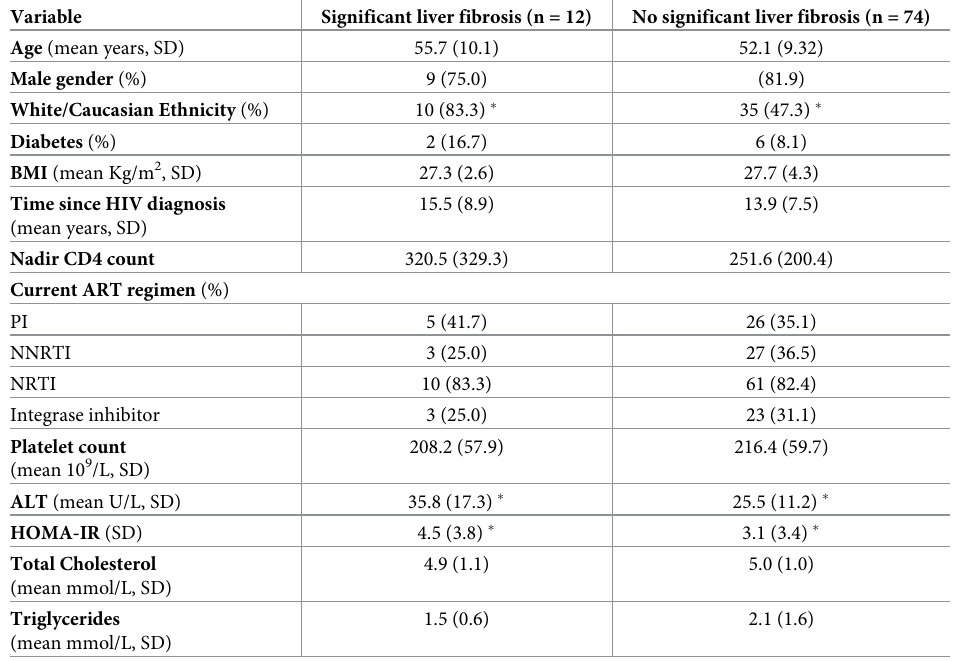
Table 2. Selected demographic, clinical, and biochemical, characteristics of 86 patients with NAFLD without NASH and univariate analysis by presence of significant liver